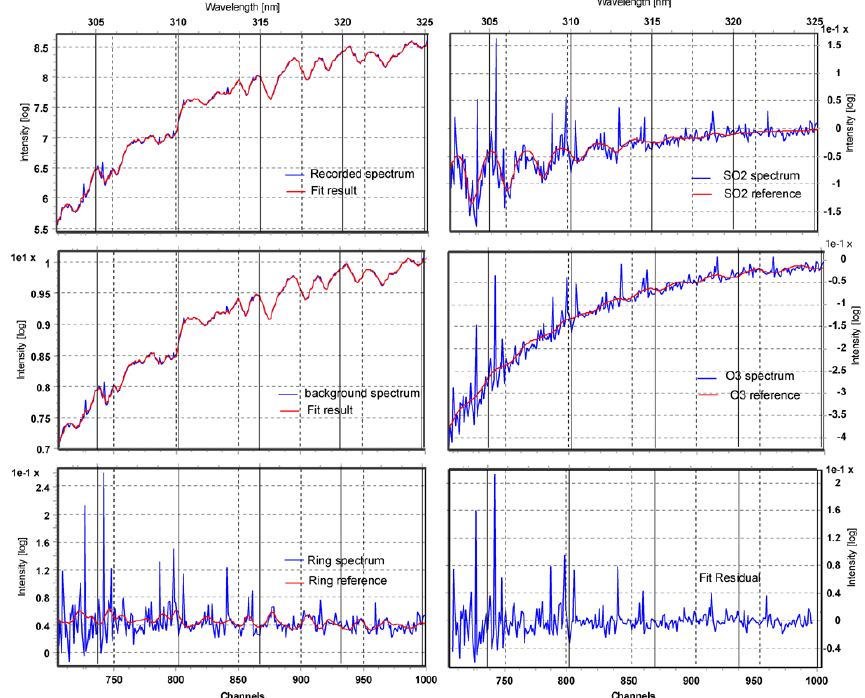
Fig. 3. Example of DOAS SO 2 fit on Papandayan. Blue lines are recorded spectra. The background spectra were acquired by pointing outside the plume. Table 2. Estimated SO 2 emission rates for Papandayan and